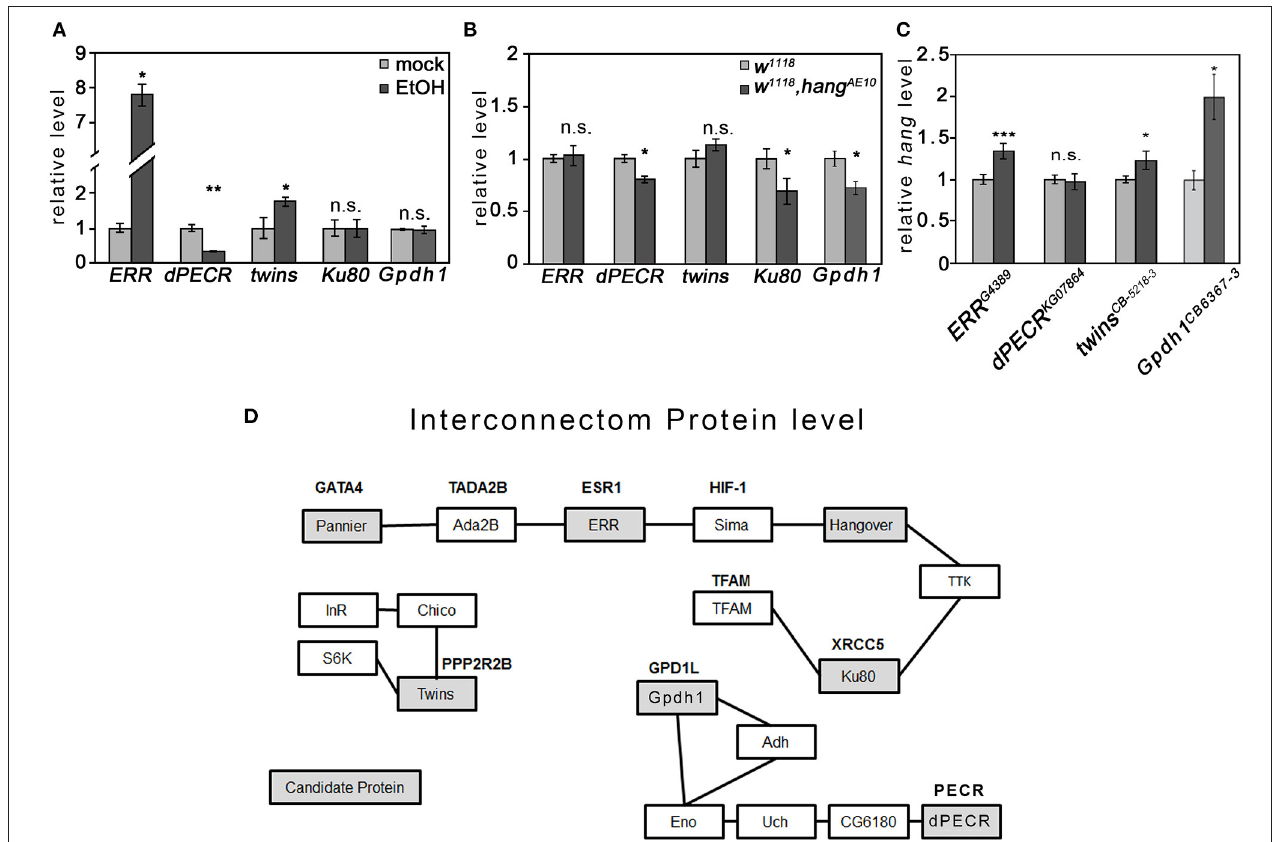
FIGURE 4 | Interaction of candidate genes and proteins. (A) Ethanol significantly increased the ERR and twins transcript levels and significantly reduced the CG10672/dPECR transcript level in the fly heads. (B) In ethanol-naïve hang AE 10 mutant flies, the CG10672/dPECR , Ku80, and Gpdh1 transcript levels were significantly reduced. (C) In ethanol-naïve ERR , twins , and Gpdh1 mutants, the hang transcripts were significantly reduced. N = 4 different RNA samples; the data are presented as the means ± STDEV. Significance was determined using a two-tailed t test. * P < 0.05, ** P < 0.01, and *** P < 0.001. (D) The interconnection analysis at the protein level was generated by a data bank analysis and was supported by experimental data as described in Supplementary Table 4